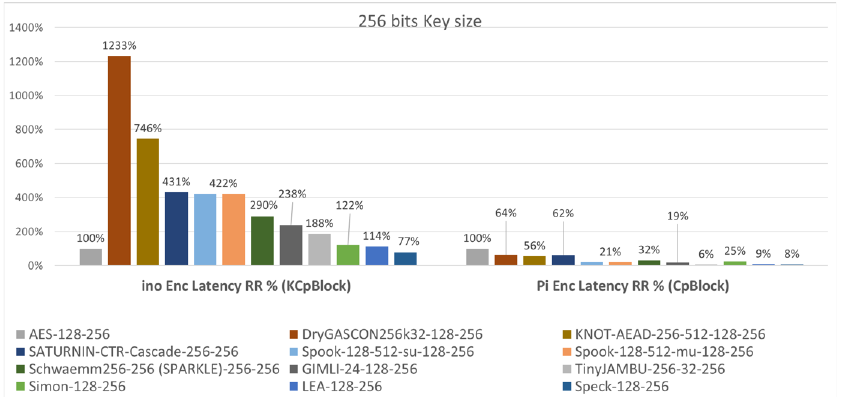
Figure 23. Group of 256-bits key size algorithms measuring ENC speed latency with respect to RR% in UNO versus Pi.